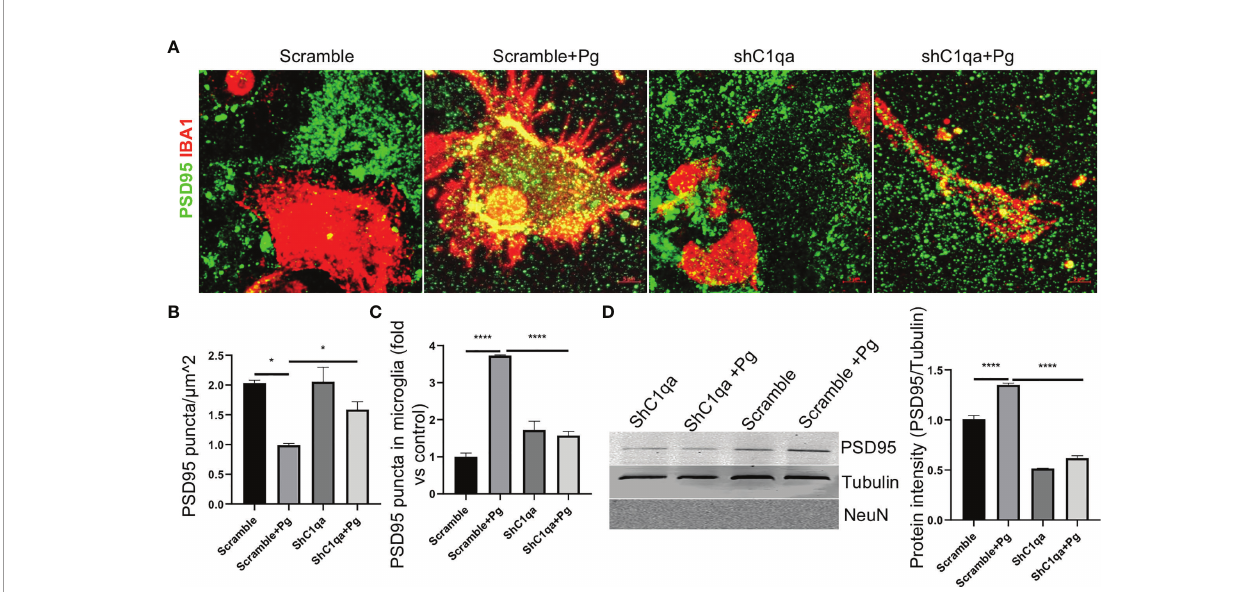
FIGURE 8 | Depletion of C1qa prevents Pg-induced synapse loss by microglia in vitro . (A) Representative Z-stack images of neuro-microglia (expressing shC1q or scramble vector) co-cultures in the presence or absence of Pg (MOI=50). Cultures were stained with IBA1 (red) and PSD95 (green). Scale bar: 5 µm. (B, C) Quanti fi cation of PSD95 puncta in the co-cultures (B) and in microglial cell bodies (C) . (D) Western blot analysis of PSD95 puncta in FACS-sorted IBA1 + microglia lysates from the co- cultures. NeuN, neuronal marker. Densitometric analysis was performed using ImageJ software, and normalized to tubulin and expressed as fold changes over scramble control. Data are expressed as mean ± SEM of three independent experiments. * P < 0.05, **** P < 0.0001 by one-way ANOVA followed with Tukey